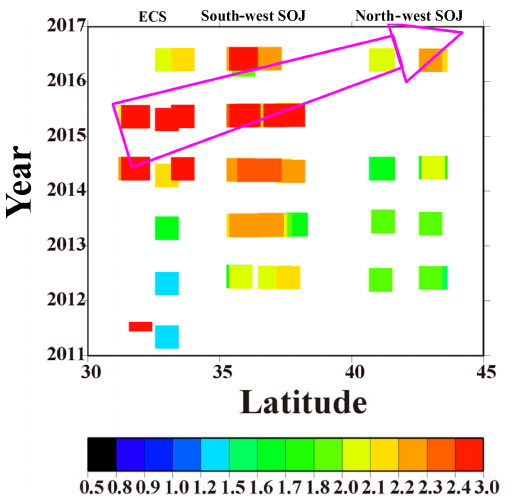
Figure 7. Hovmöller diagrams of the 137 Cs activity concentra- tions at a potential water density anomaly of 25 . 2 ± 0 . 5kgm − 3 along with an eastern TWC. The ECS stations described on the x axis are Kagoshima and Saga stations. The south-western SOJ includes the monitoring stations Shimane, Fukui, Ishikawa and Ni- igata. The north-western SOJ includes the monitoring stations Ao- mori and Tomari. Colour indicates the 137 Cs activity concentrations (Bqm − 3 ) .